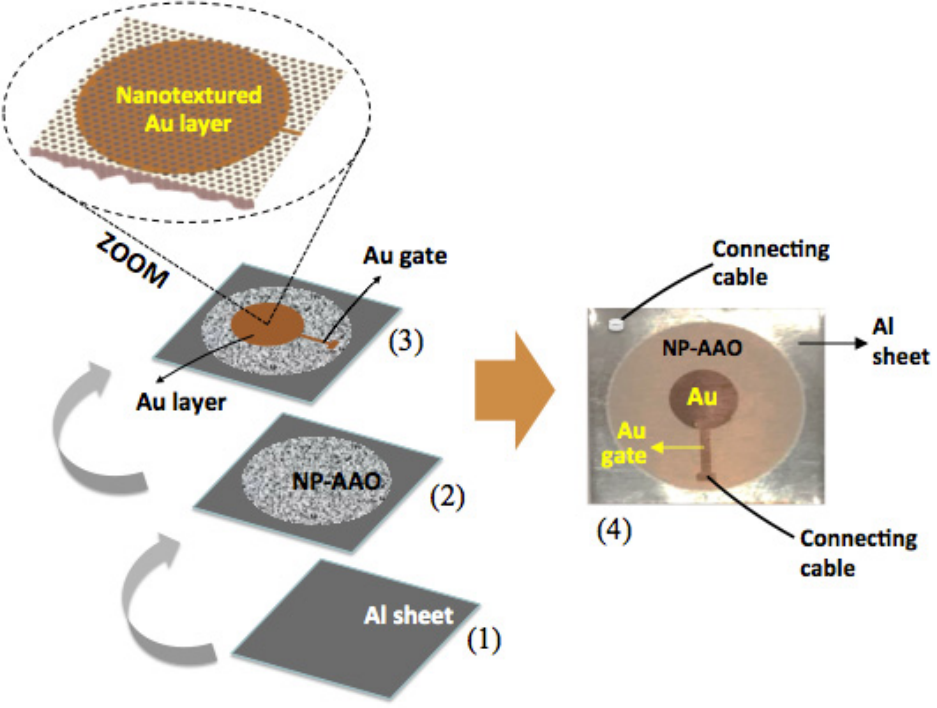
Figure 3. Schematic representation of the capacitive-type sensor: ( 1 ) the starting Al-sheet, which works as the bottom electrode of the capacitive-type sensor; ( 2 ) development of the NP-AAO layer by one-step anodization technique; a circular alumina layer (20 mm in diameter) was grown after anodization, comprising the dielectric material; ( 3 ) a circular nanotextured Au thin layer (diameter of 7.5 mm) is directly deposited by sputtering on the surface of the alumina layer, which acts as the sensor’s top electrode, and ( 4 ) the photograph of the final architecture of the sensor is presented. It is emphasized that the direct deposition of a gold thin film on the surface of the nanoporous alumina enables the formation of a nanoporous Au structure with a nanotex- tured surface topography. This nanoporous and nanotextured Au layer plays an important role, as it has to allow water vapour (application as a capacitive humidity sensor) or a liquid medium of bacterial culture (application as a capacitive touch sensor) to enter through it in order to be adsorbed by the dielectric material, that is, the nanoporous alumina layer. The top Au electrode is of circular geometry with a diameter of 7.5 mm and is linked to a gold compact gate with a length of 5 mm; this arrangement was attained through the use of a specific mask, which was mechanically fabricated from an aluminium foil. The inclusion of a compact gold gate is to prevent the thin nanotextured Au layer from being damaged when applying the electrical connection cable to the sensor’s top electrode. Electrical connections are taken from the two electrodes by using conductive silver glue